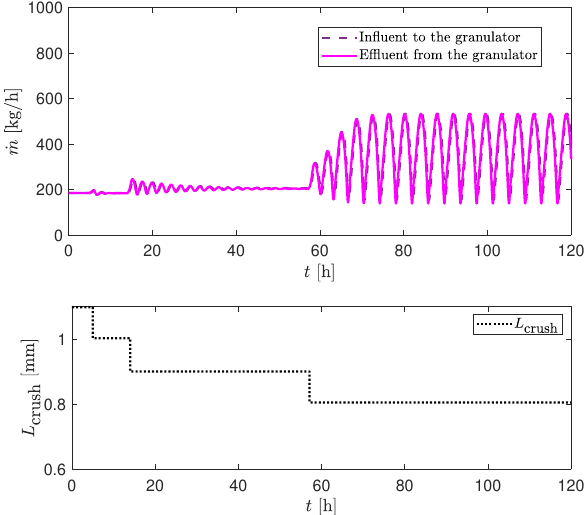
Figure 8: Total mass flow rates of the influent/effluent as a response to the step-by-step change of the crusher gap ( L crush = 1 . 1 → 1 . 0 → 0 . 9 → 0 . 8